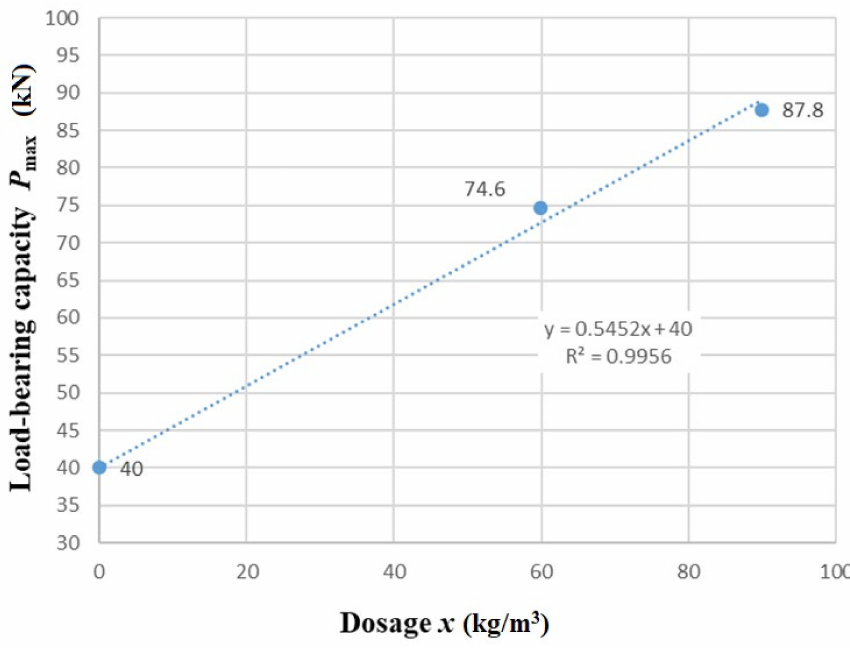
Figure 20. Load-bearing capacity—reinforced concrete beam without shear reinforcement. Span: 900